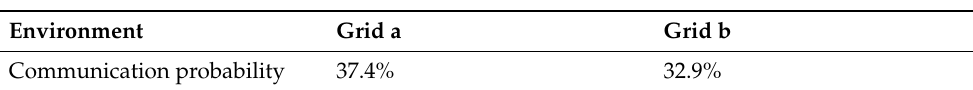
Table 2. Communication probability in power grid environment. The communication penalty is set to r comm-penalty = −